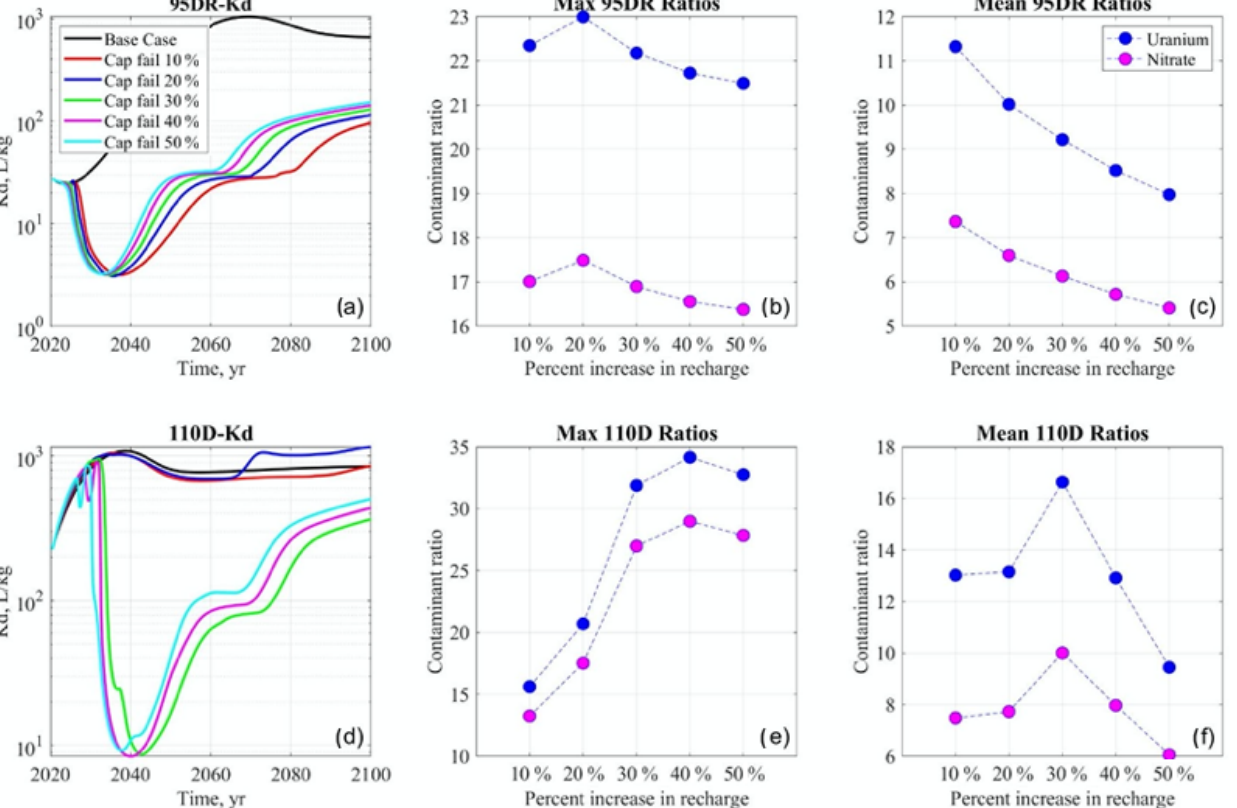
Figure 11. Breakthrough curves for K d at the source-zone well (a–c) and the downgradient well (d–f) for the increasing recharge scenario from 2020 to 2100. Maximum and average ratios of base case to increased recharge case for uranium and nitrate concentrations at both well